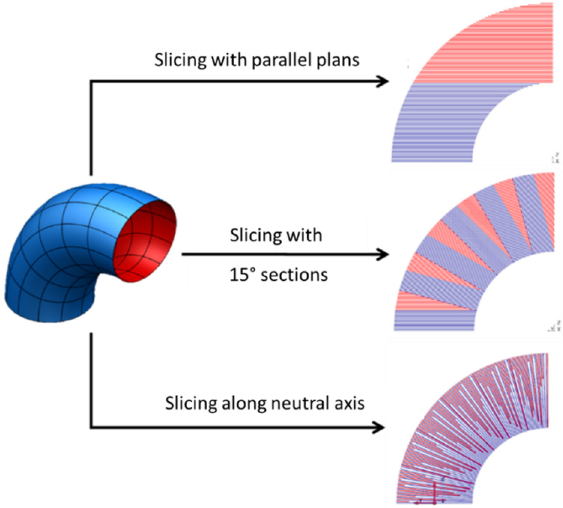
Figure 4. Several slicing strategies for a single geometry.